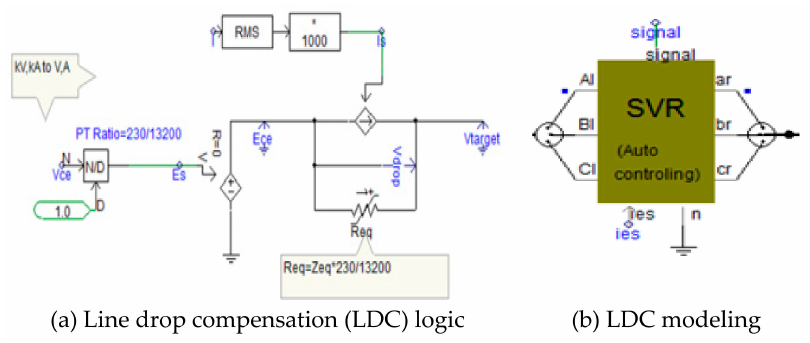
Figure 4. Line drop compensation (LDC) model of SVR.